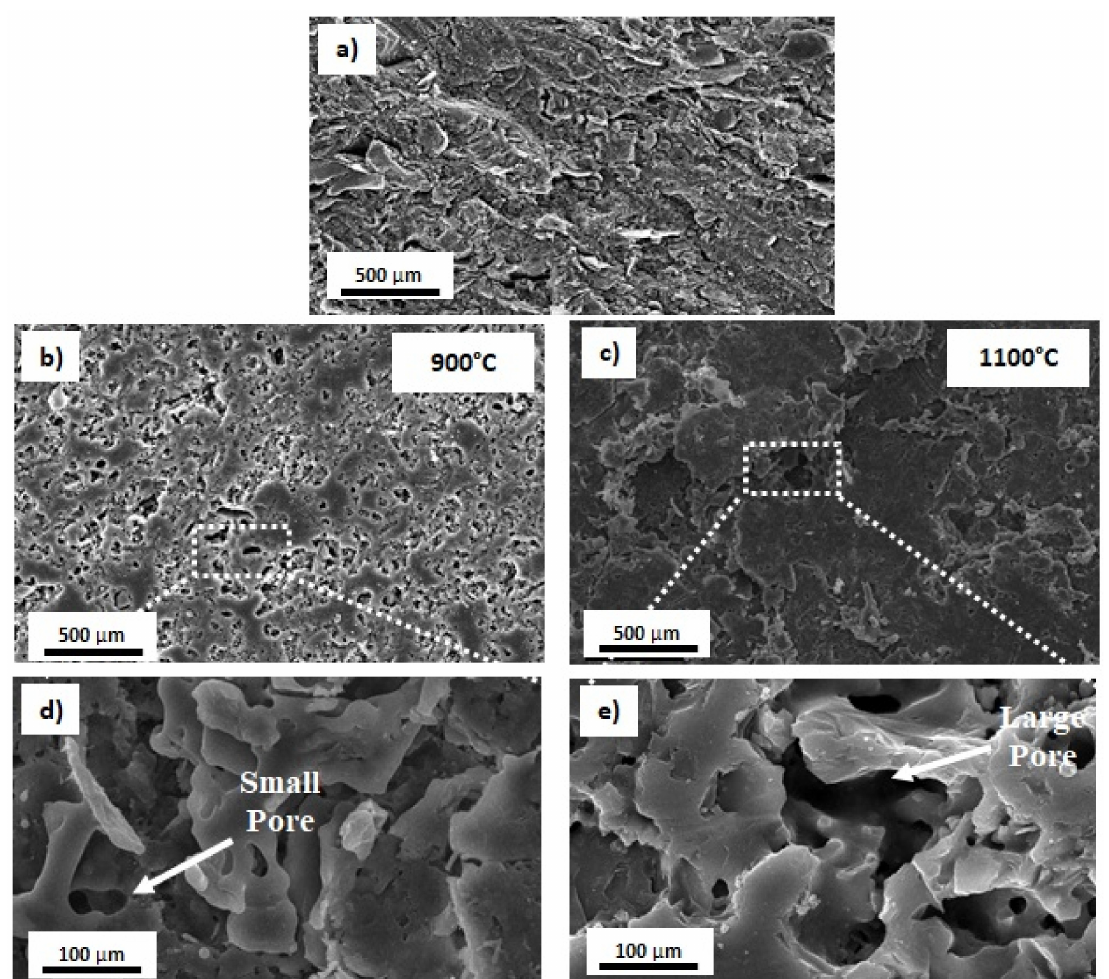
Figure 5. SEM micrograph of ( a ) unsintered, ( b , d ) sintered at 900 ◦ C, and ( c , e ) sintered at 1100 ◦ C kaolin-based